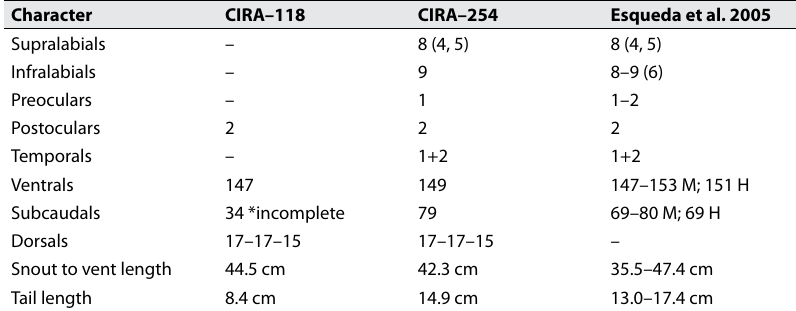
Table 1. Scales counts of Erythrolamprus dorsocorallinus specimens collected from the Reserva de Biósfera Estación Biológica del Beni, Bolivia. Missing values indicate unavailable